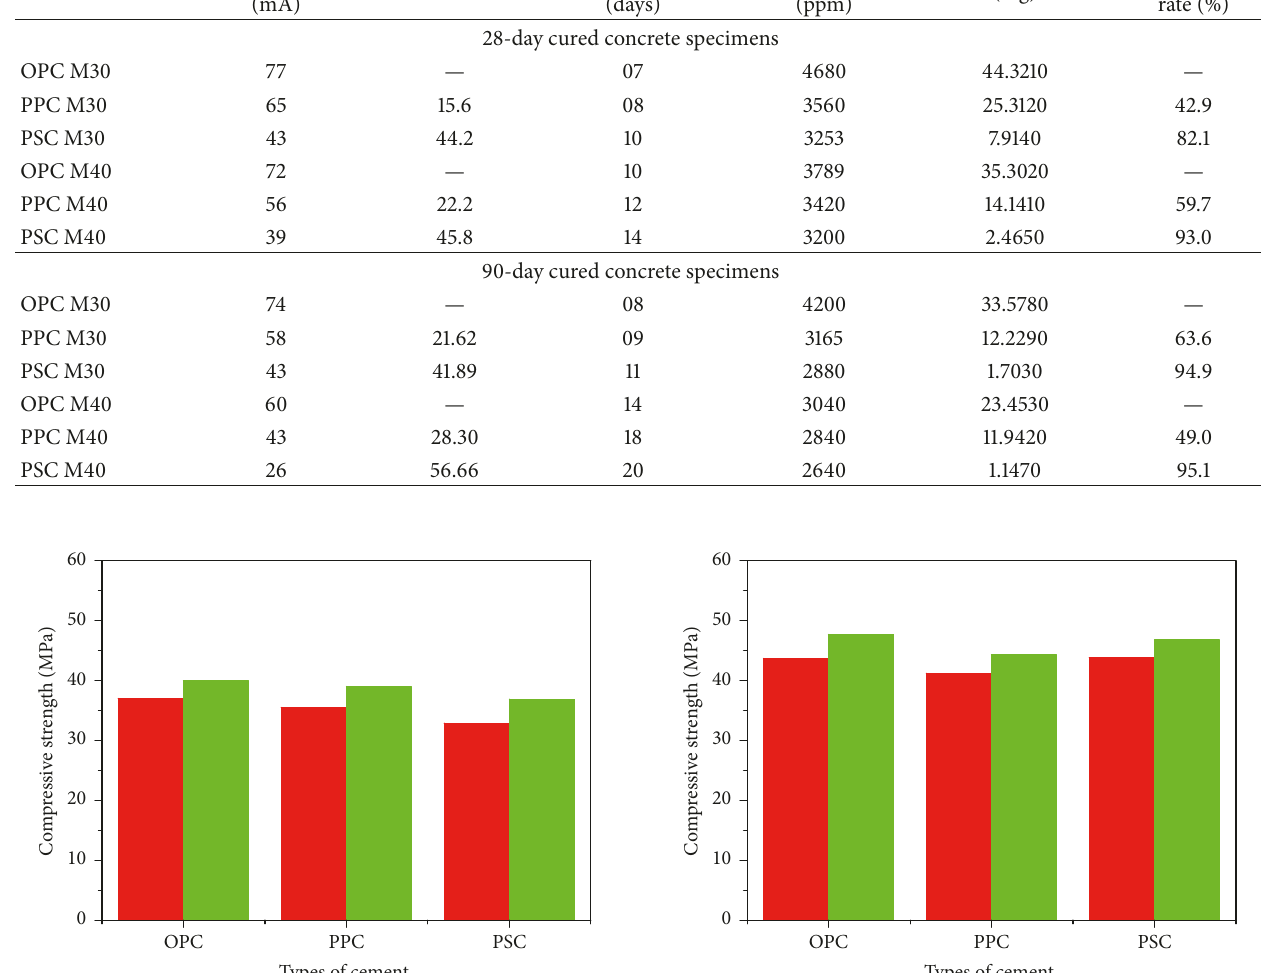
Table 4: Impressed voltage parameters for rebar in OPC, PPC, and PSC M30 and M40 grade concrete types. Grade and type